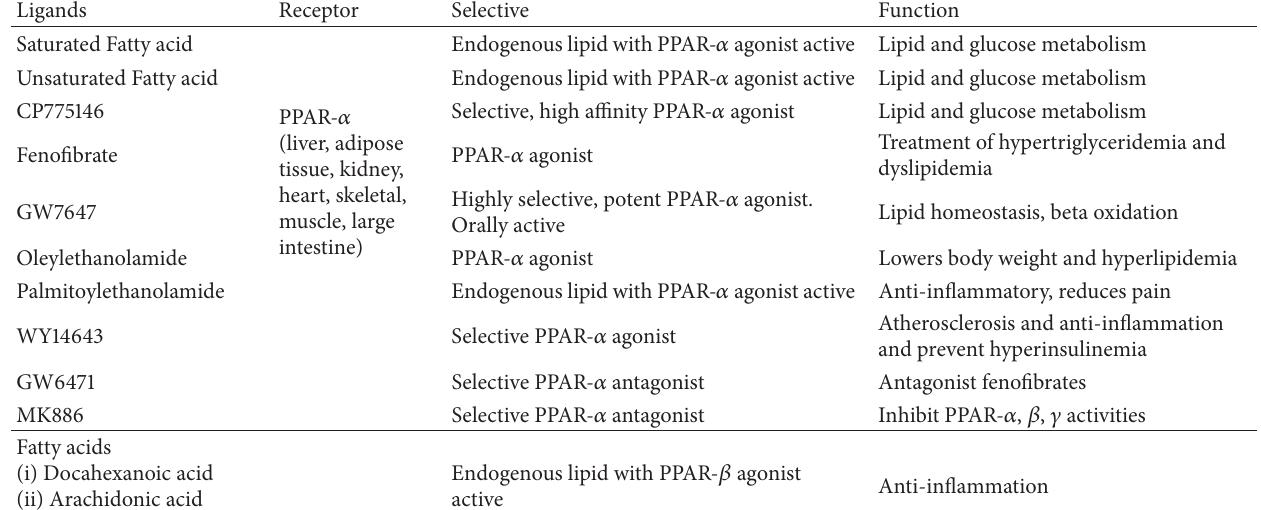
Table 1: Potential targets of PPARs for prevention and treatment of metabolic